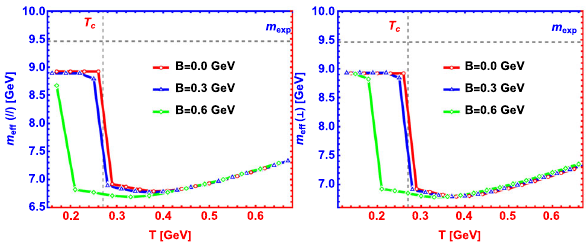
Fig. 6 Left:Thespectralfunctionofthe J /(cid:2) stateforparallelcaseand perpendicular case at T = 0 . 3GeV ,μ = 0GeV. Right: The effective mass of the J /(cid:2) state for parallel case and perpendicular case at B = 0 . 3GeV ,μ = 0GeV